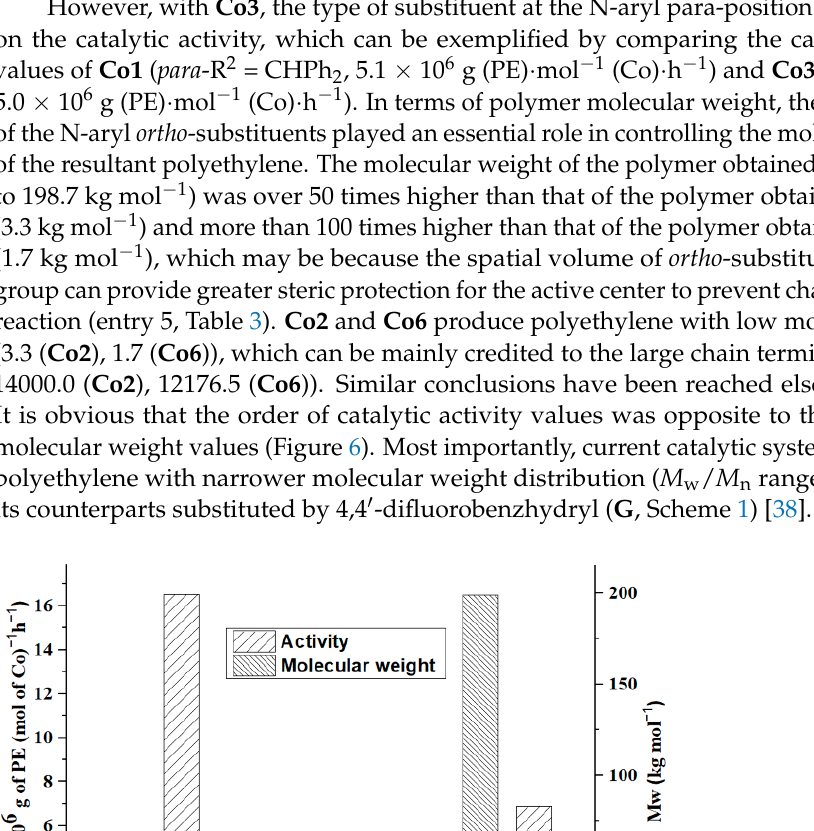
Table 4. Catalytic evaluation using Co6 /MMAO as the test system a .